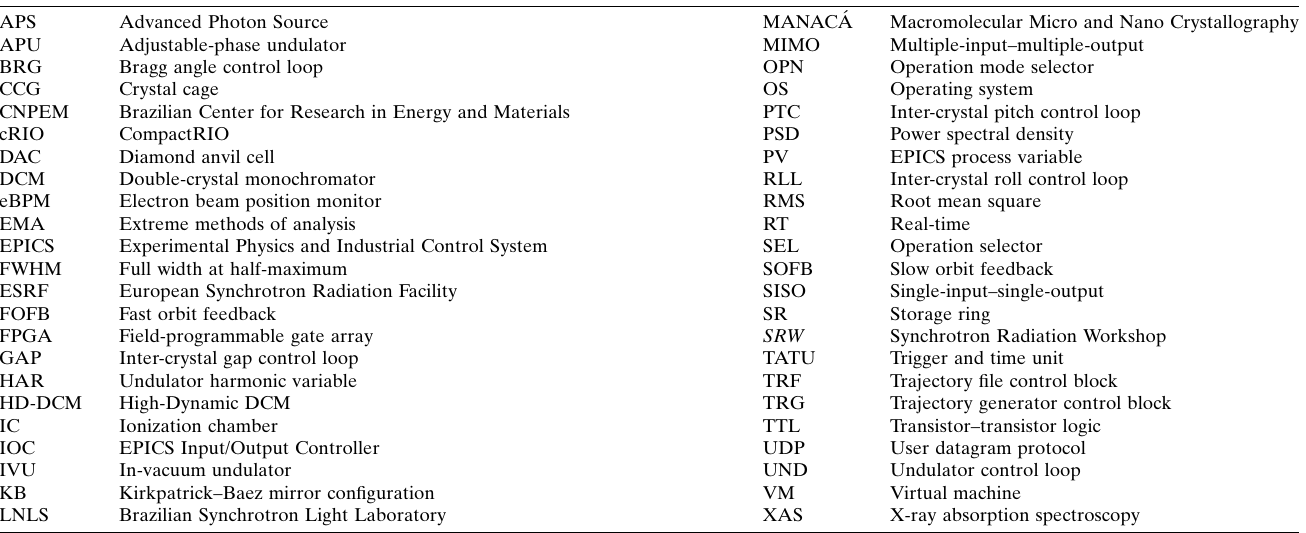
Table 1 List of abbreviations used in this